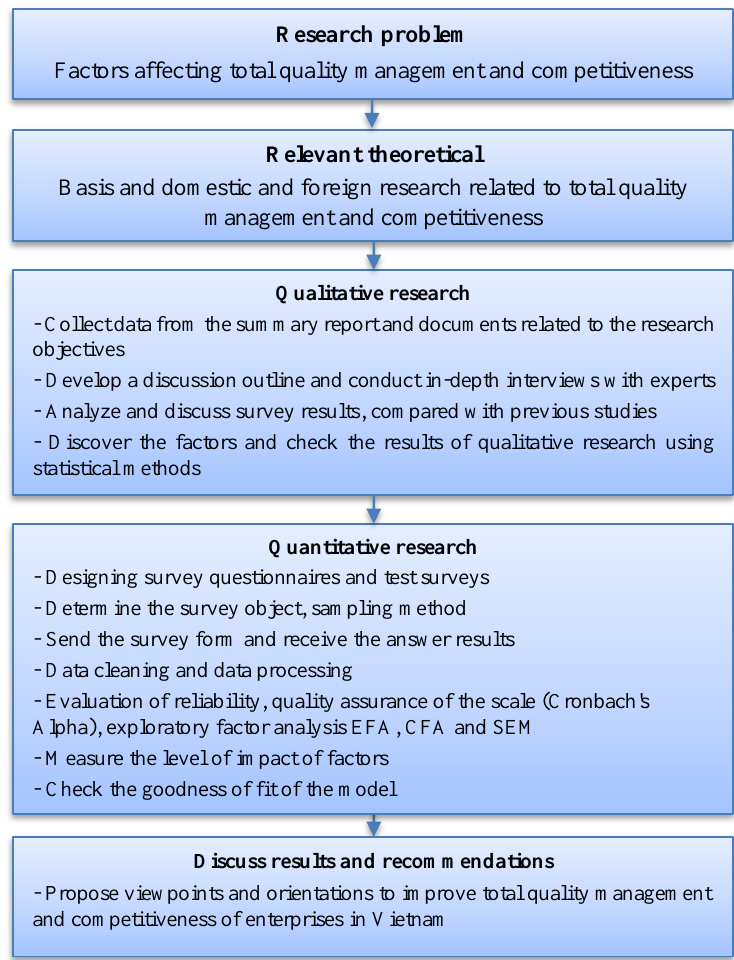
Discuss results and